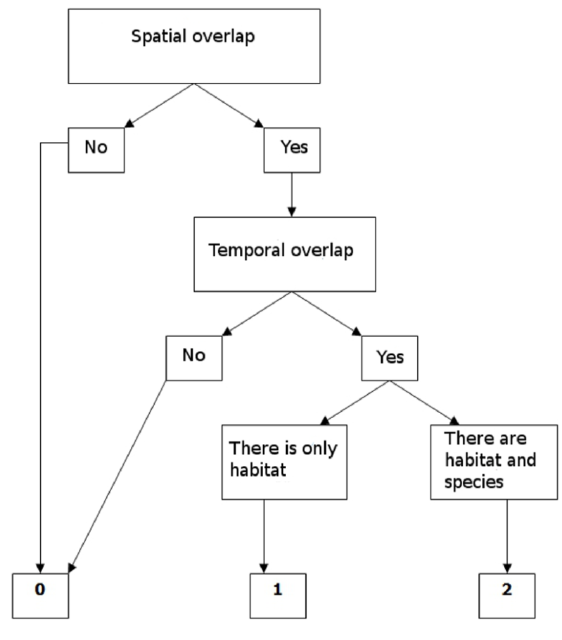
Figure 6. Flow chart for spatial and temporal